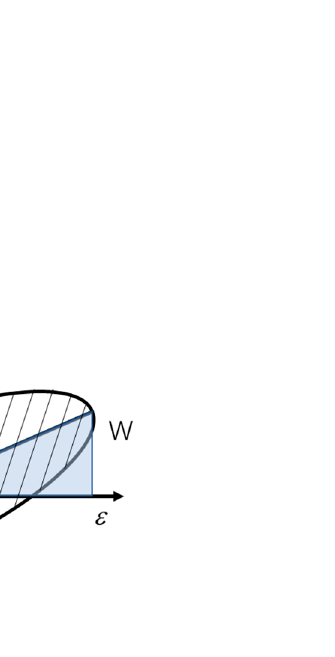
Figure 2. Calculation of the equivalent damping ratio.